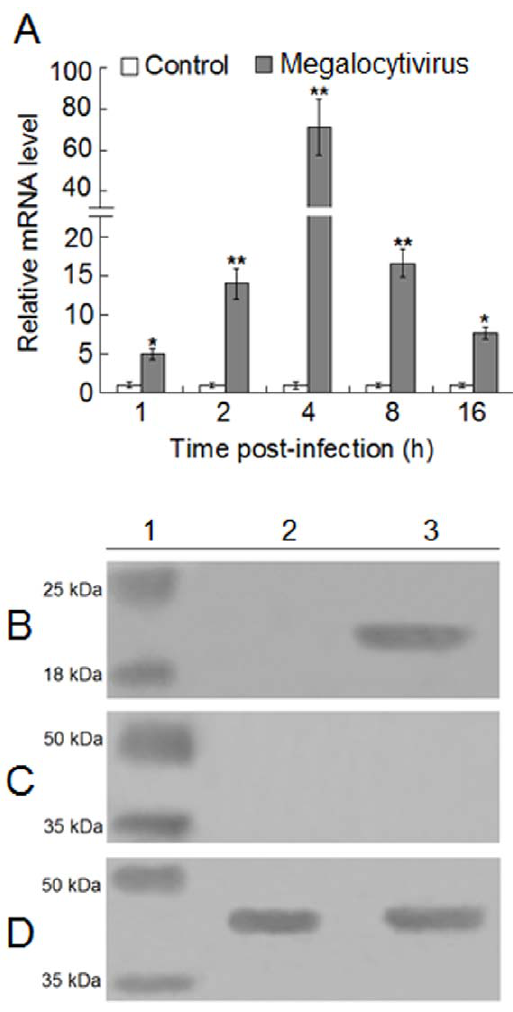
Figure 5. Expression and localization of CsISG15 in lympho- cytes. (A) Tongue sole head kidney (HK) lymphocytes were infected with or without (control) megalocytivirus, and CsISG15 expression was determined by quantitative real time RT-PCR at various time points. At each point, the expression level of the control cells was set as 1. Values are shown as means 6 SE (N = 3). N, the number of repeated experiments. ** P , 0.01, * P , 0.05. (B, C, and D) Tongue sole HK lymphocytes were infected with (lane 3) or without (lane 2) megalocytivirus for 4 h, and extracellular proteins were subjected to immunoblot with antibodies against CsISG15 (B) or b -actin (C). To demonstrate that the b -actin antibody was able to detect b -actin when it was present, cytoplasmic proteins were prepared and blotted with b - actin antibody (D). Lane 1, protein marker. doi:10.1371/journal.pone.0044884.g005 extracellular milieu as it was observed with human ISG15, HK lymphocytes were infected with or without megalocytivirus for 4 h, which, as shown above, was the point when drastic CsISG15 induction was observed. Extracellular proteins were prepared from the culture supernatant and subjected to immunoblot analysis with antiserum raised against recombinant CsISG15 (Figure S1 and Figure S2) or with antibody against b -actin. The results showed that CsISG15 was detected in the culture supernatant of megalocyti- virus-stimulated cells but not in that of unstimulated cells (Fig. 5). Since no b -actin was detected in the protein preparations, it is not likely that the detected CsISG15 was due to cell lysis.